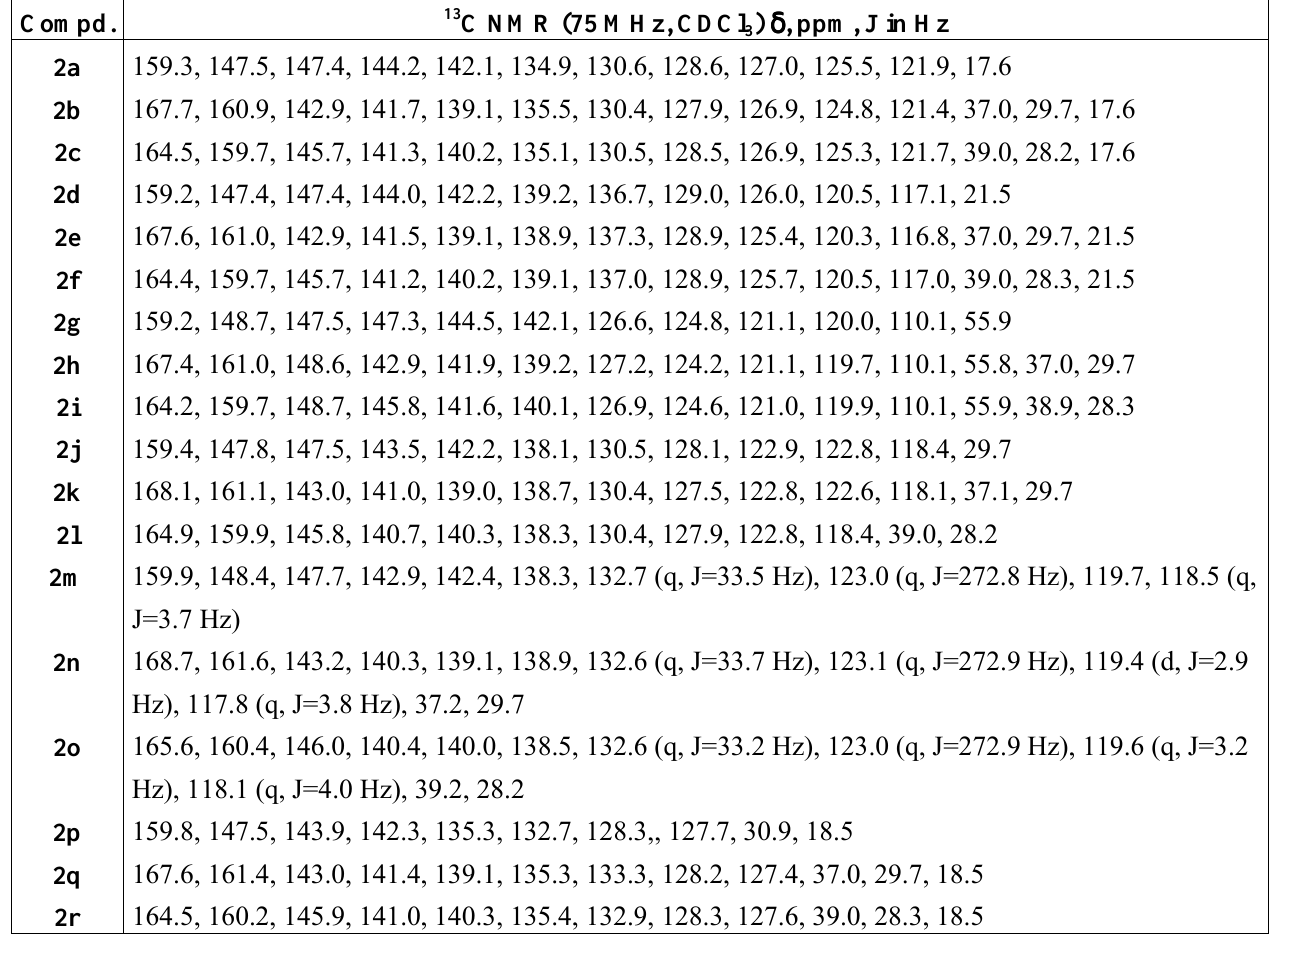
Table 5. 13 C NMR spectral data of the amides 2a-r